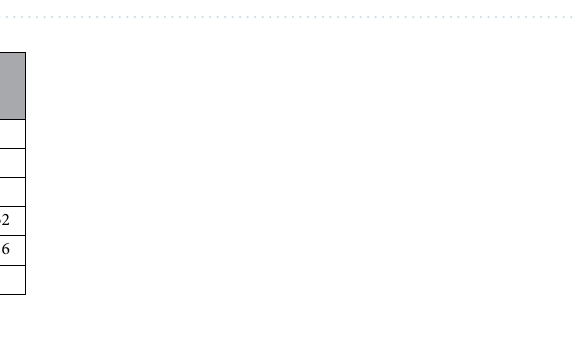
Figure 2. The network architecture of ( a ) up-sampling block ( b ) convolution block ( c ) residual block1 ( d ) residual block2 ( e ) output block ( f ) classification block.